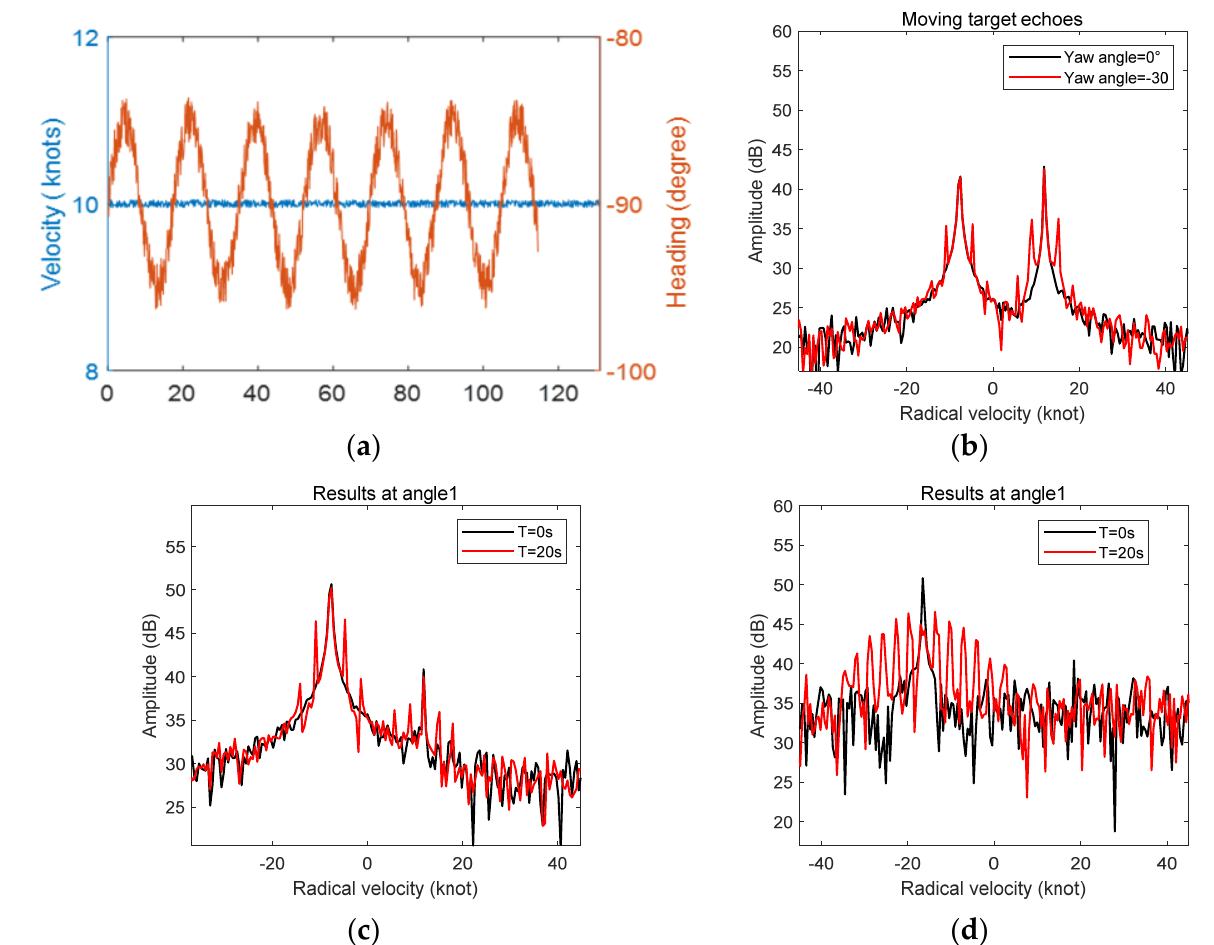
Figure 9. Simulation results when the yaw angle varies periodically: ( a ) the distribution of the velocity and heading of the platform, ( b ) channel results when Vp = 0 knot, ( c ) beam simulation result of target 1 when Vp = 0 knot, ( d ) beam simulation result of target 1 when Vp = 10 knot.